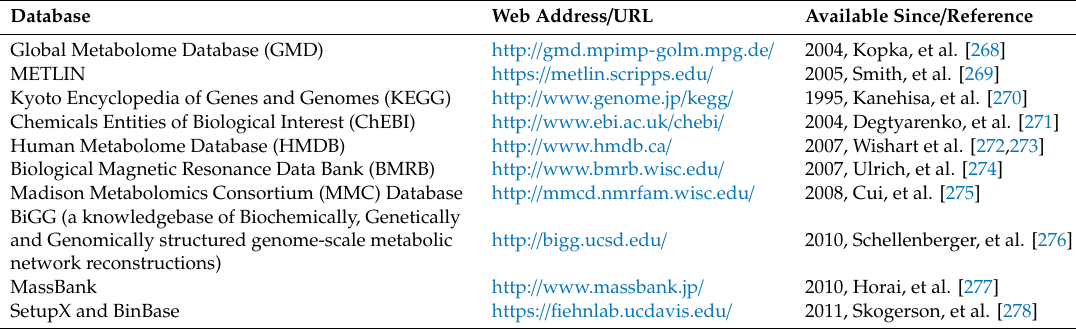
Table 4. Web-based databases for identification of metabolites (modified from